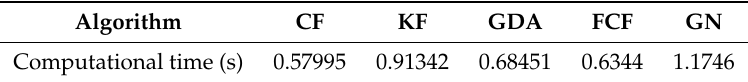
Table 3. Computational time of executing each algorithm.